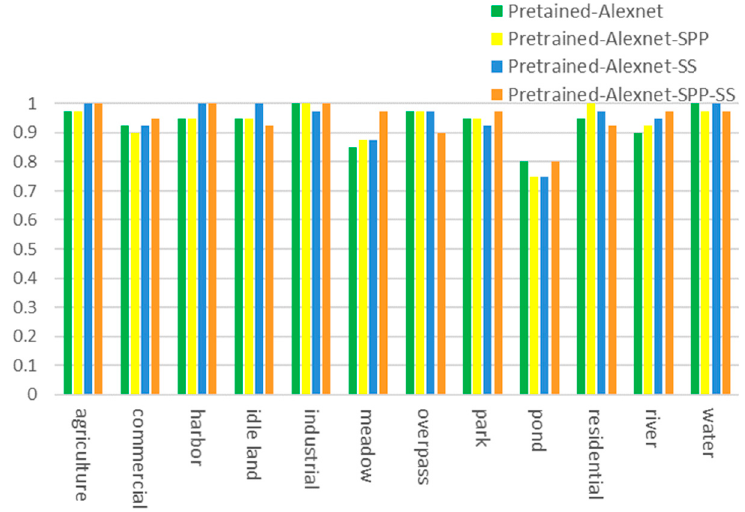
Figure 11. Classification accuracies of each category for different algorithms with the Google image dataset of SIRI-WHU.